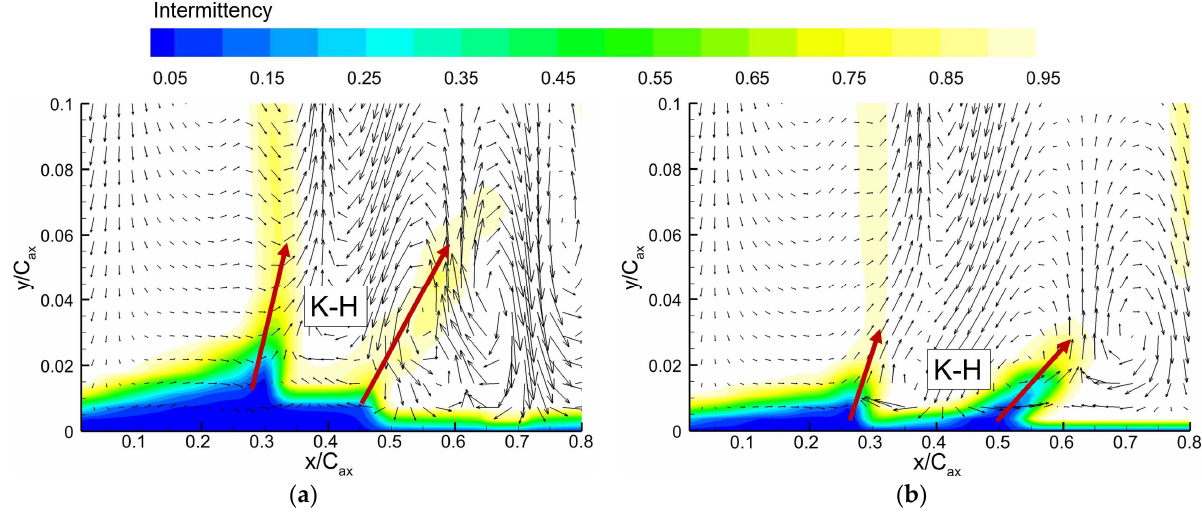
Figure 16. Distribution of the transient intermittency and K-H instability on the suction surface at 50% span. ( a ) Re = 1 × 10 5 ; ( b ) Re = 4 × 10 5. 50% span. ( a ) Re = 1 × 10 5 ; ( b ) Re = 4 × 10 5